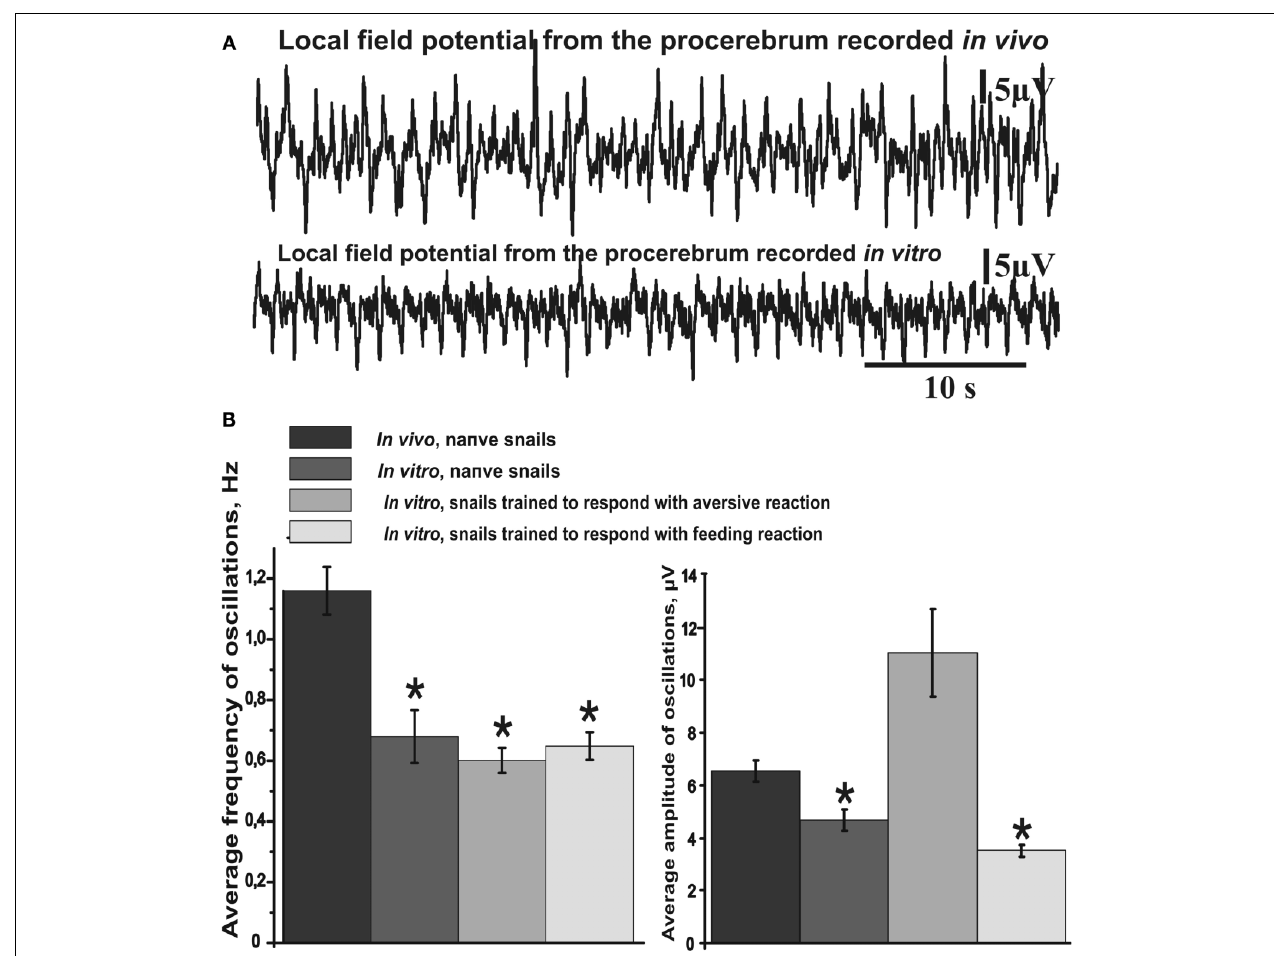
FIGURE 2 | Average frequency and amplitude of spontaneous procerebral oscillations during in vivo and in vitro recordings without odor application. (A) Local fi eld potential from the procerebrum. The amplitude and frequency of the procerebral oscillations recorded in vivo undergo frequent spontaneous changes whereas the frequency and amplitude of the oscillations recorded